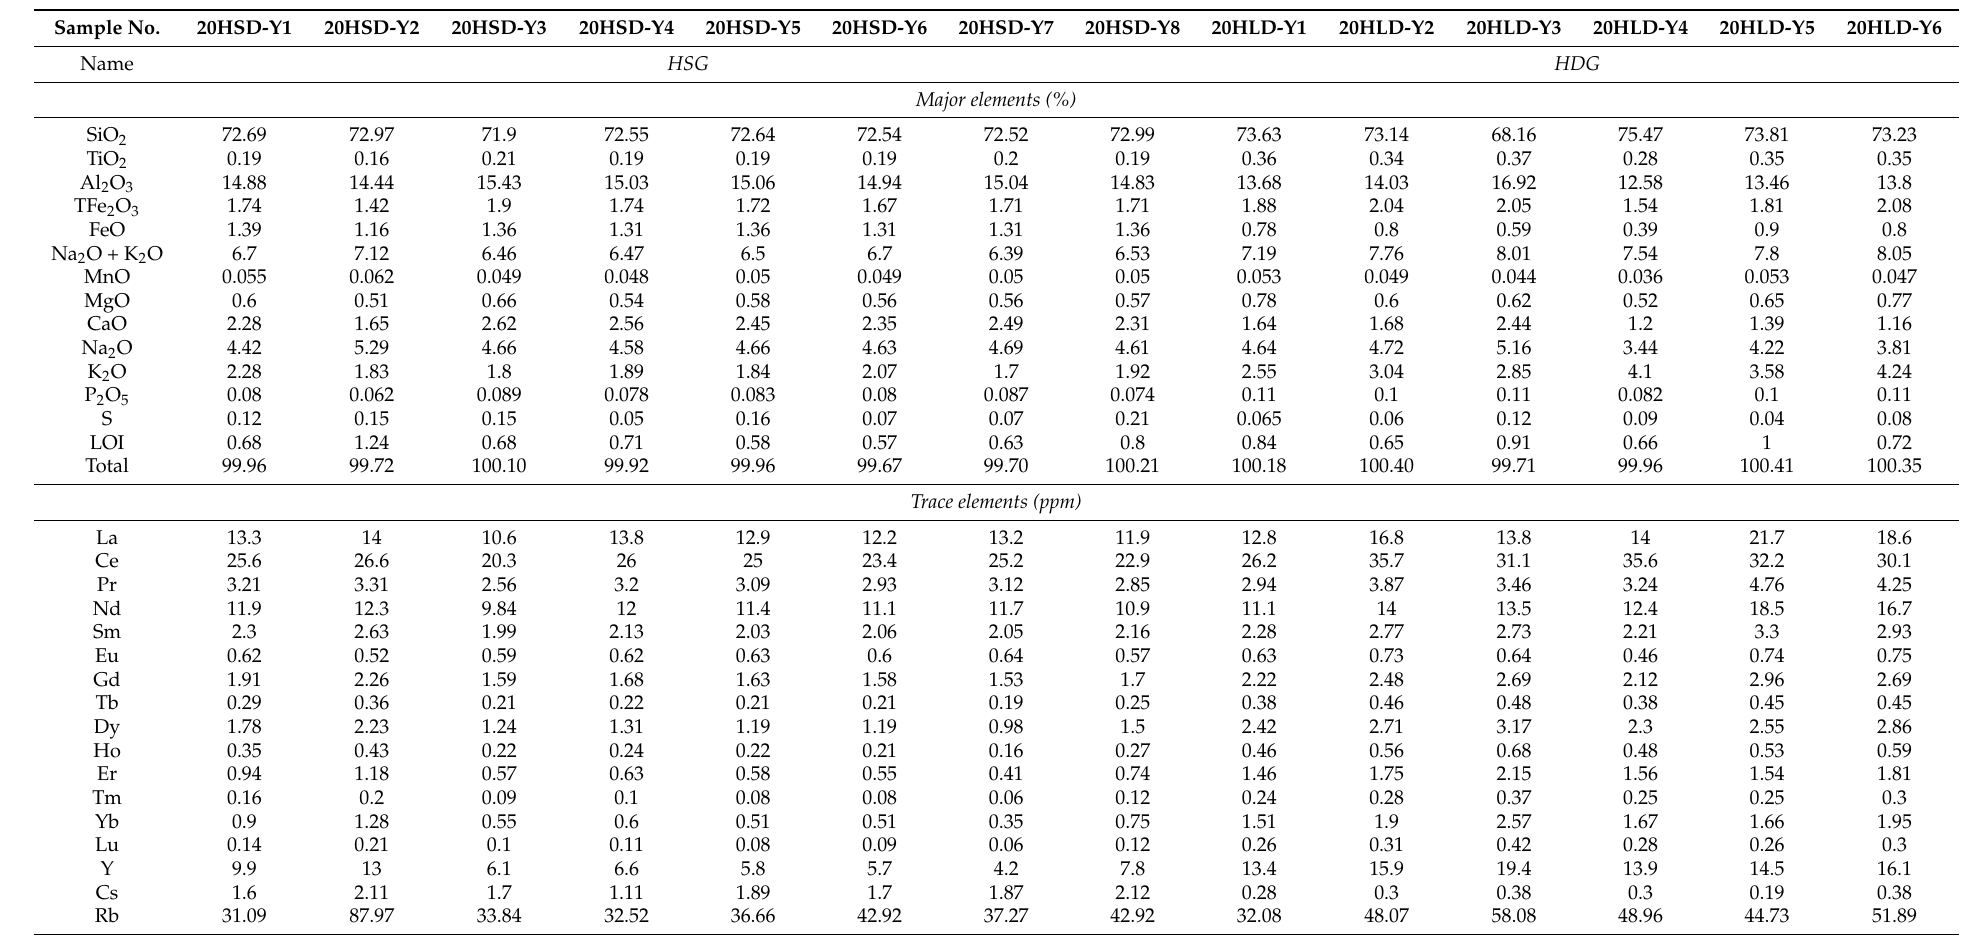
Table 7. Whole-rock geochemical compositions of the HSG and HDG of the